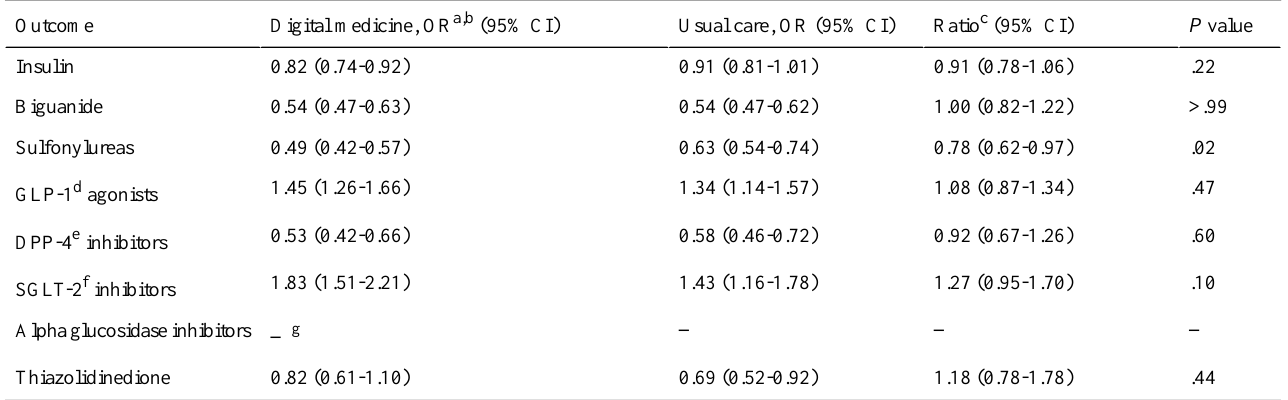
Table 8. ORs of medication use at 12 months by group.